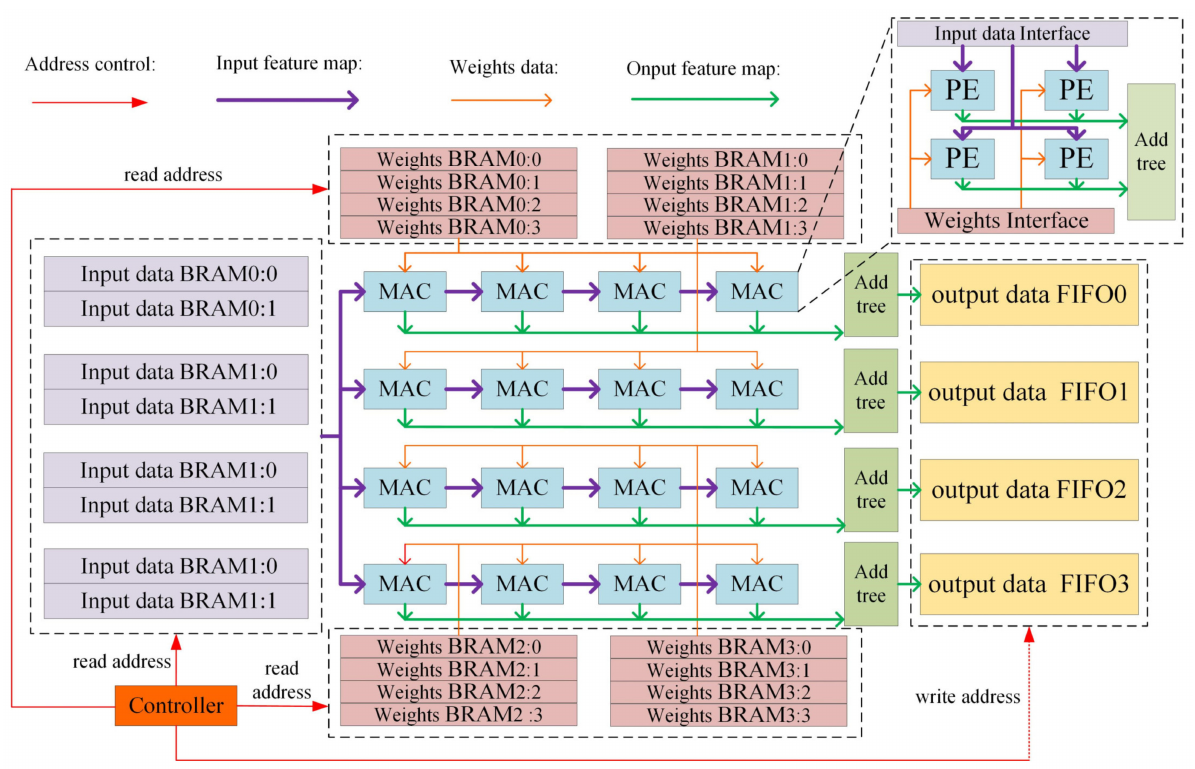
Figure 6. Multichannel Shared Computation architecture.